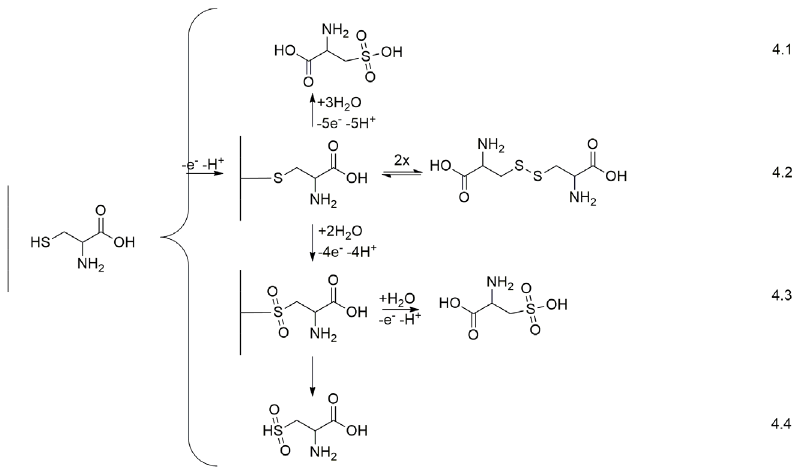
Figure 5 - Oxidation pathways proposed in the literature for the oxidation of L-Cys by 4.1 and .2 (Davis and Bianco 1966), 4.3 (Pradac and Koryta 1968) and 4.4 (Feliciano- Ramos et al.